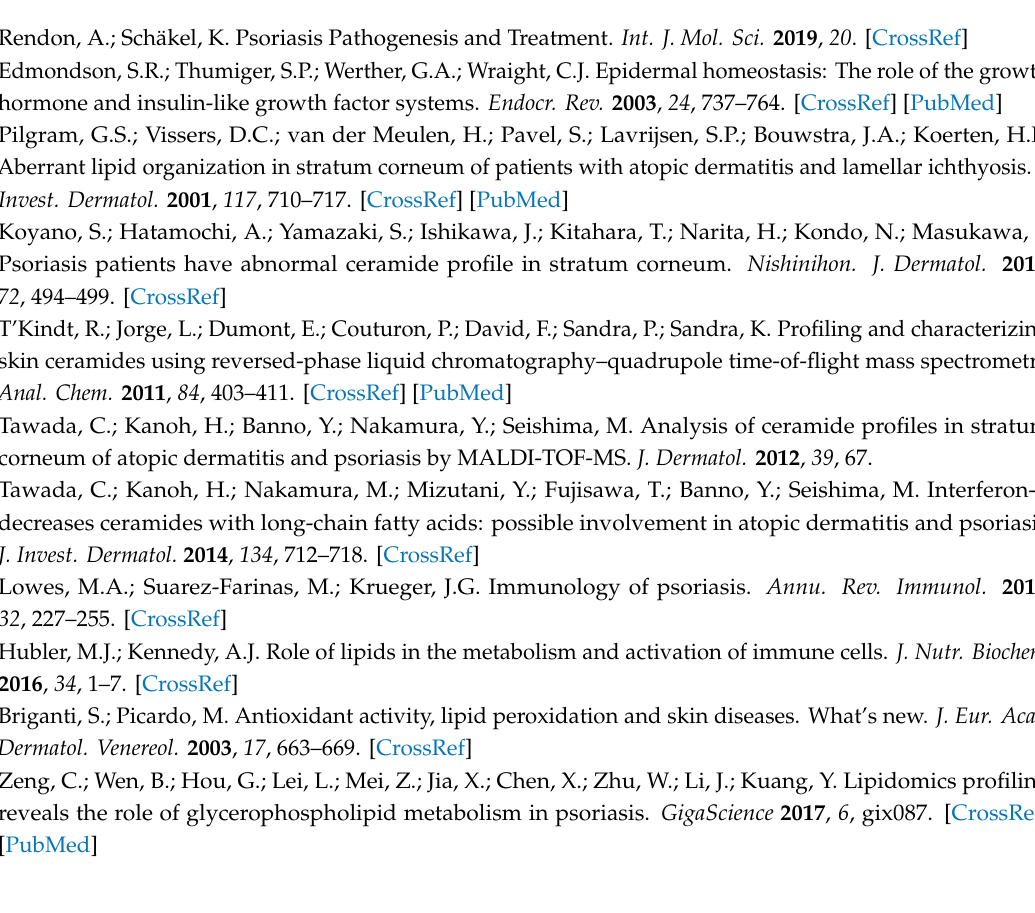
Supplementary Materials: Table S1. MS-based identification of the ceramide molecular species quantified in the present study, Table S2. Peak area of each ceramide molecular species identified in the keratinocytes obtained using MZmine software (XLSX), Table S3. Peak area of each ceramide molecular species identified in the fibroblasts obtained using MZmine software (XLSX), Figure S1. An example of the total ion chromatogram (TIC), Figure S2. And Figure S3. Examples of CER specie